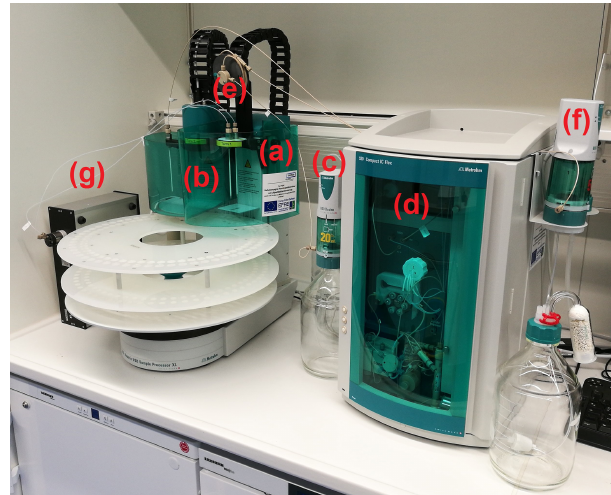
Figure 1. Setup of the IC system with (a) the first working station and (b) the second working station of the autosampler, (c) the 800 Dosino for the sample transportation, (d) the Compact IC, (e) the 10mL sample loop, (f) the 800 Dosino for the gradient system and (g) an external six-way valve for the combination of MARGA and the IC